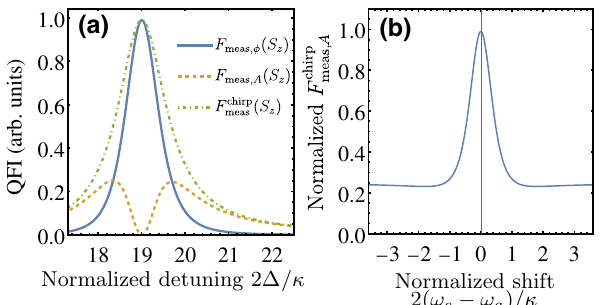
FIG. 6. (a) QFI per scattered photon per atom for different types of measurements. The blue solid line and the yellow dashed line correspond to the amplitude and phase components of the total QFI F A and F φ , respectively. The green dotted line repre- for a chirped two-color measurement of the sents the QFI F chirp A transmission amplitude through the cavity, which equals the total QFI F A + F φ . (b) The normalized total QFI for a chirped two- color measurement as a function of the cavity-atom detuning. The QFI is quite sensitive to the symmetry of the transmission lineshape; see the